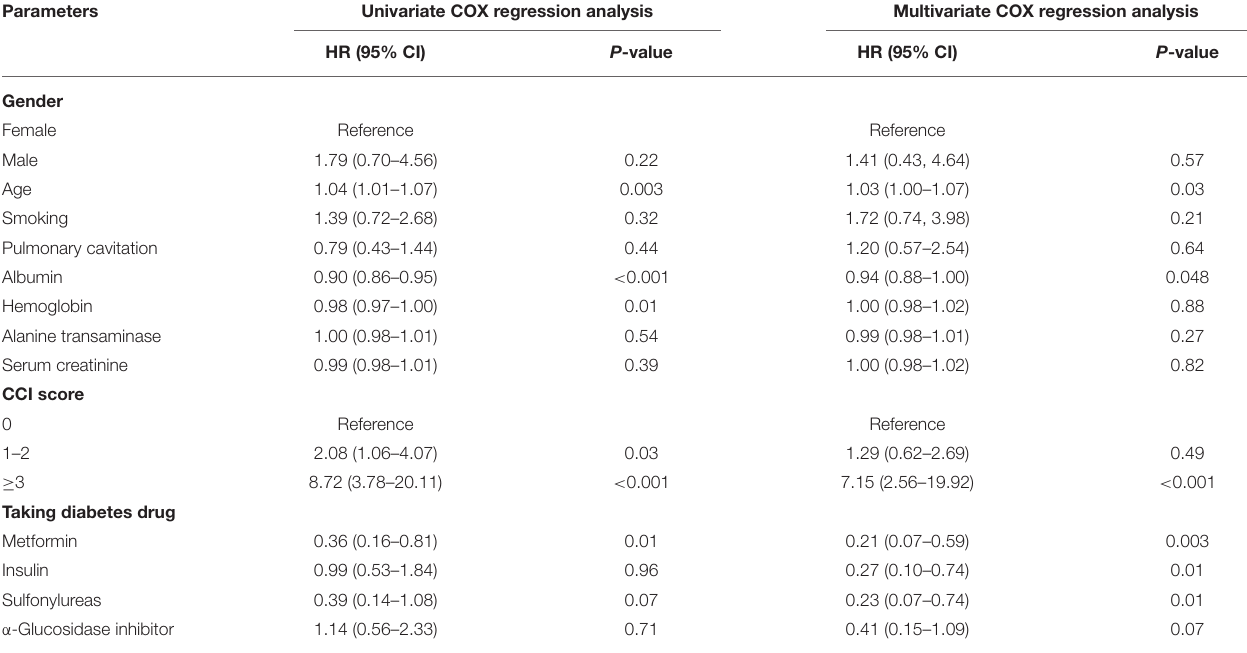
TABLE 3 | COX regression analysis of the long-term all-cause death in patients with pulmonary TB and type 2 diabetes comorbidity.